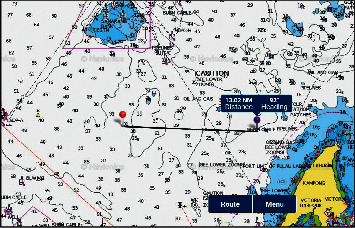
The width distance of area D (Labuan) fishing ground. The nature seabed in this area is sand and mud. The coordinates for area Labuan D are as follows: L1: 5°32′4.74″N 115° 4′54.54″E; L2: 5°24′37.98″N 115°10′2.76″E; L3: 5°17′45.18″N 115° 6′9.96″E; and L5: 5°27′52.68″N 114°47′59.22″E (Figure 5).